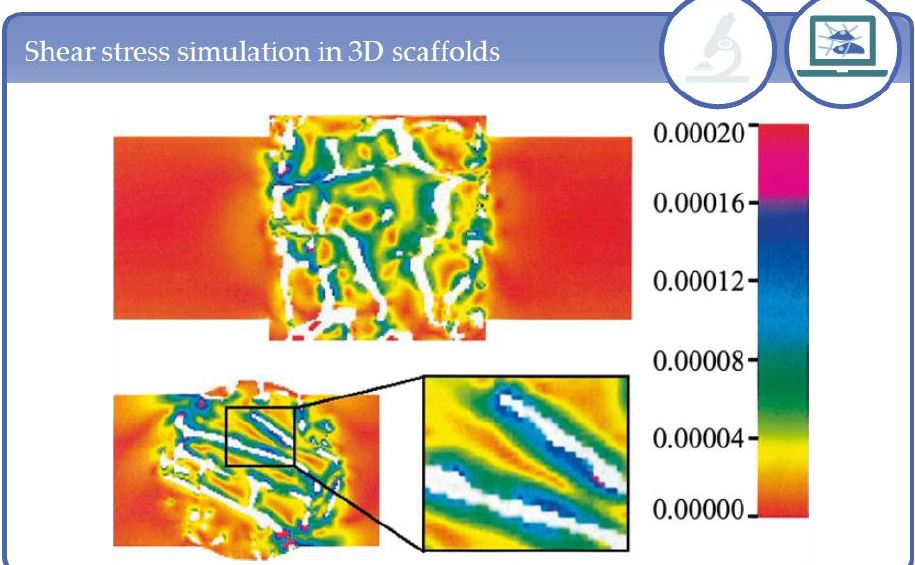
Figure 27. Local shear stress field: map of shear stresses (Pa) in media transversely perfused through a 3D trabecular bone scaffold from side and top views. Reprinted from [242] with permission of Elsevier.